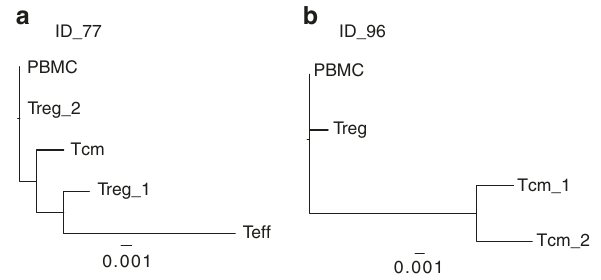
Fig. 4 Phylogenies of ampli fi ed chimeric HIV/STAT5B bands. Maximum- likelihood trees constructed aligning the haplotypes identi fi ed analyzing the HIV-1 sequence from the U5 to the major SD signal among different hematopoietic cell subsets for patients ID_77 and ID_96. The hematopoietic cell subset from which the speci fi c haplotype was identi fi ed is indicated at each branch tip of the tree. The progressive number indicates different haplotypes that have been identi fi ed within the same hematopoietic cell subset. Branch length varies according to the number of substitutions as a proportion of the length of the alignment (Distance value). Scale bar is reported below each